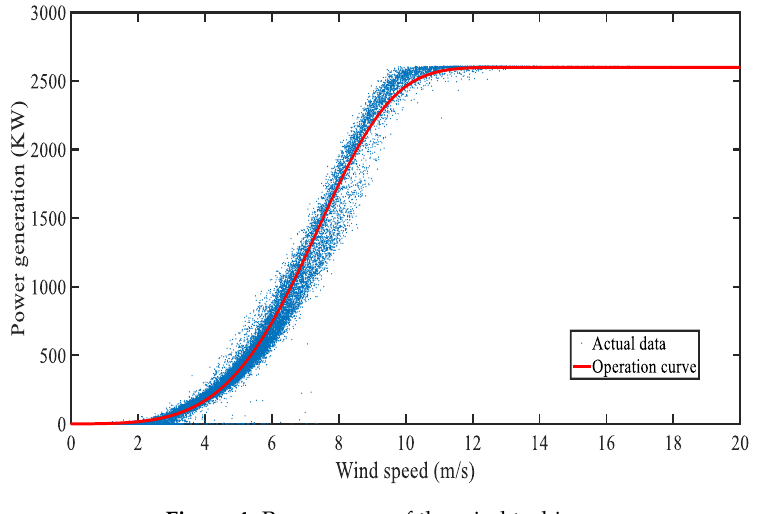
Energies 2019 , 19 , x FOR PEER REVIEW Figure 4. Power curve of the wind turbine. Figure 4. Power curve of the wind turbine.